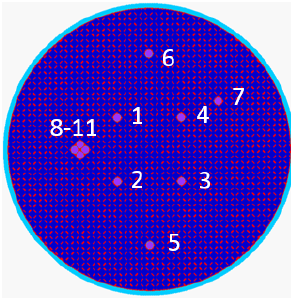
Figure 1. Reactor core model(Top view)